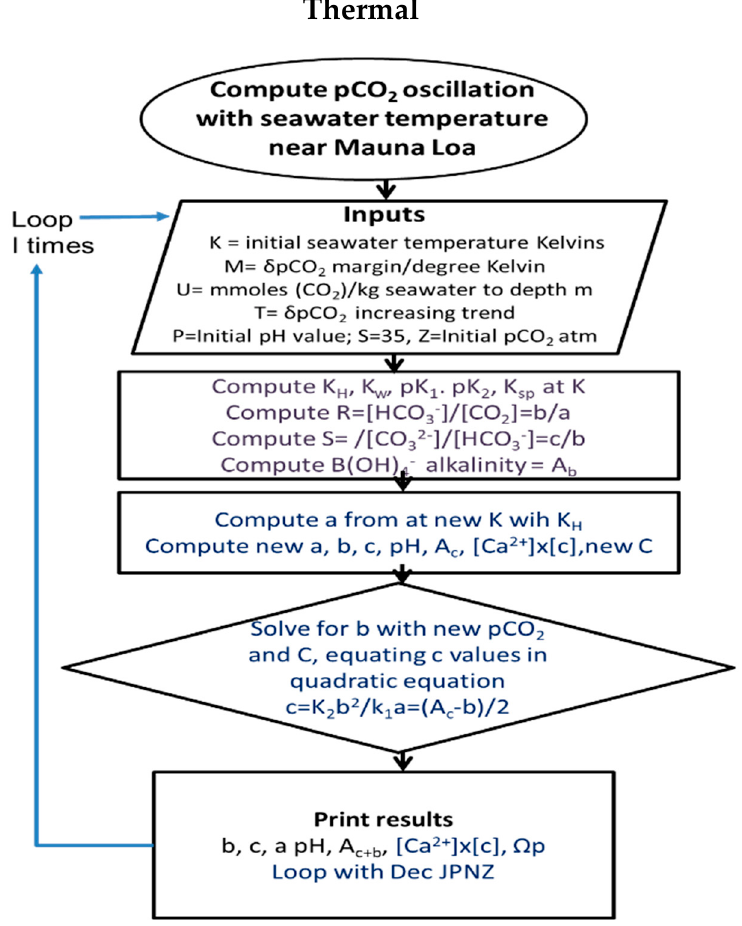
Figure 4. Flow diagrams for Thermal programs, generating changes in p CO 2 in response to changes in temperature. A copy of the code is provided as Supplementary Material or directly from the corresponding author.